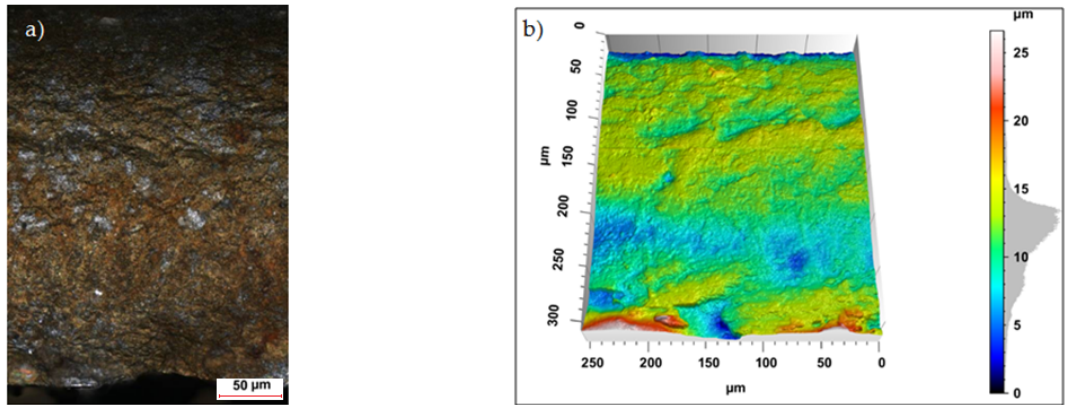
Figure 6. Views of the surface of the cut edge ( h c = 0.08 mm and v = 10.2 m/min): ( a ) surface pho- tography, ( b ) surface topography (coated steel).